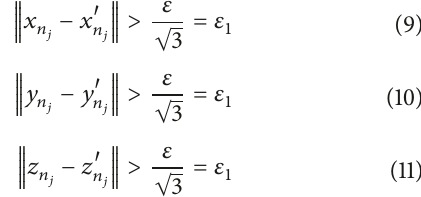
Figure 2: The schematic of system G